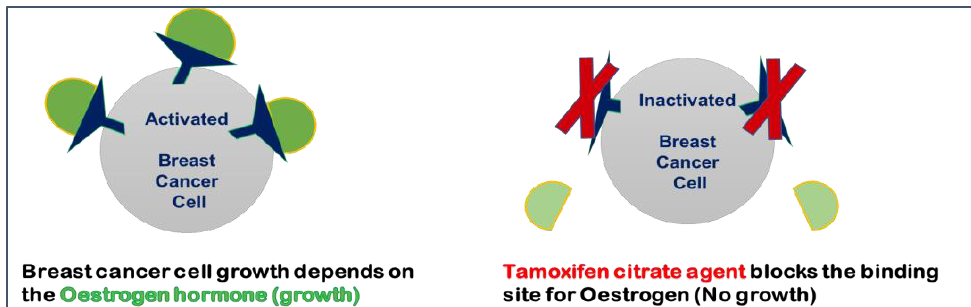
Figure 1. Tamoxifen is capable of blocking the oestrogen hormone receptor on the breast cells, thereafter, cancer cells cannot grow when they are not activated.